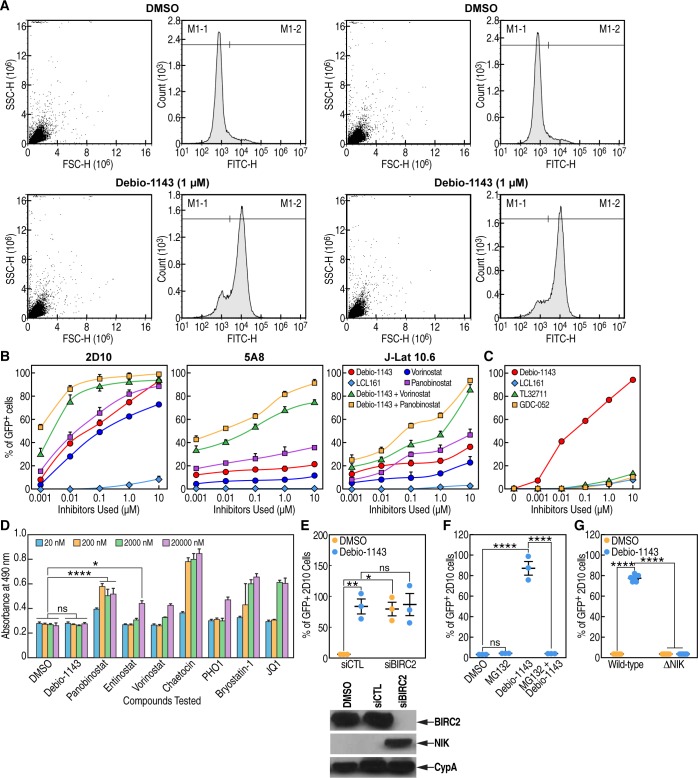
Debio 1143 reverses HIV-1 latency.A. Typical FACS graphs for the percentage of GFP+ HIV-1 latent reporter cells. The population on the forward scatter/side scatter dot plot was placed by the automatic scaling feature of the cytometer. Minor variability between reporter cell replicates was observed as shown by representative graphs of 2D8 cells treated with control DMSO or Debio 1143 (1 μM). B. Latently infected JLat 10.6, 2D10 and 5A8 GFP reporter cells (250,000) (duplicate) were treated for 48 h with LCL161 (1 μM), Debio 1143 (1 μM) or in combination with panobinostat (10 nM) and vorinostat (500 nM). GFP expression was quantified by FACS. Data are expressed as % of GFP levels. Two distinct experiments were conducted in triplicate and averaged data are presented. C. Same as B except that the capacity of Debio 1143 at reversing HIV-1 latency in 2D10 cells was compared with that of other IAPa. D. CD4+ T-lymphocytes (250,000) (triplicate) were incubated with the LRAs and cytotoxicity was quantified after 48 h by LDH assay as above (Fig 2). E. 2D10 cells were treated with control (siCTL) and BIRC2 (siBIRC2) siRNA for 24 h, then incubated with DMSO or Debio 1143 (1 μM) and analyzed for GFP expression after 48 h (left panel) and cell lysates analyzed by Western blotting for BIRC2, NIK and CypA expression. F. 2D10 cells (triplicate) were first incubated with or without MG132 (25 μM) for 30 min, subsequently exposed to DMSO or Debio 1143 (1 μM) for 48 h, and analyzed by FACS for GFP content. G. Wild-type or NIK knockout (ΔNIK) 2D10 cells were exposed to DMSO or Debio 1143 (1 μM) for 48 h, and analyzed by FACS for GFP content. Two distinct experiments were conducted in triplicate and averaged data are presented. P-values are presented. ANOVA and Bonferroni’s multiple comparison tests were used to compare means of different groups. Bar graphs indicate each sample point, mean, and SEM. Key for adjusted p-values from Bonferroni’s multiple comparison tests on graphs: ns = no significance, * = 0.01≤p<0.05, ** = 0.001 ≤p<0.01, *** = 0.0001≤p<0.001, and **** = p<0.0001.